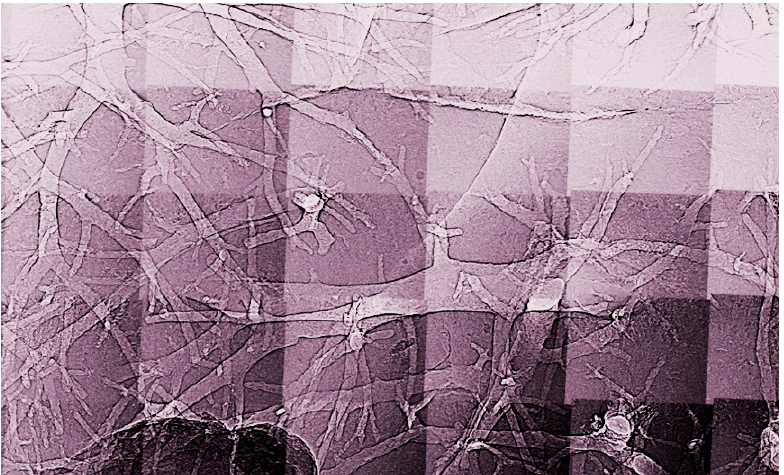
Figure 1. An example of a coherence-based radiograph: the enhanced edges of microscopic vessels in a mouse liver [13]. Horizontal image size: 4.2 mm.